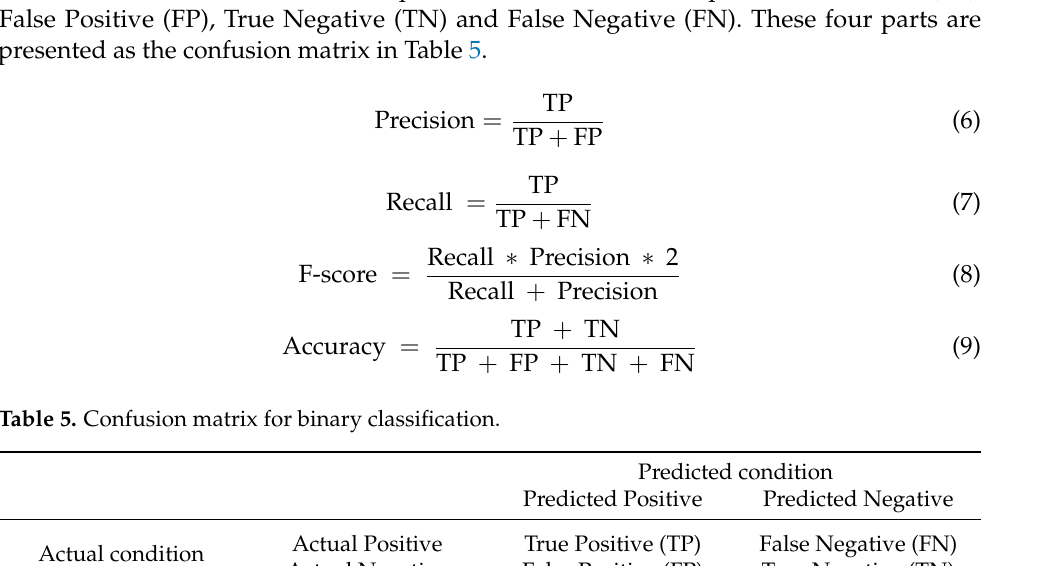
Table 4. Parameters selected for optimization process under XGBoost algorithm. Hyperparameter Description From To By Maximum number of edges Maximum depth from the node to the tree’s root node Minimum sum of weights of all Minimum child weight observations required in a child Ratio of observations for Subsample sampling to construct each tree